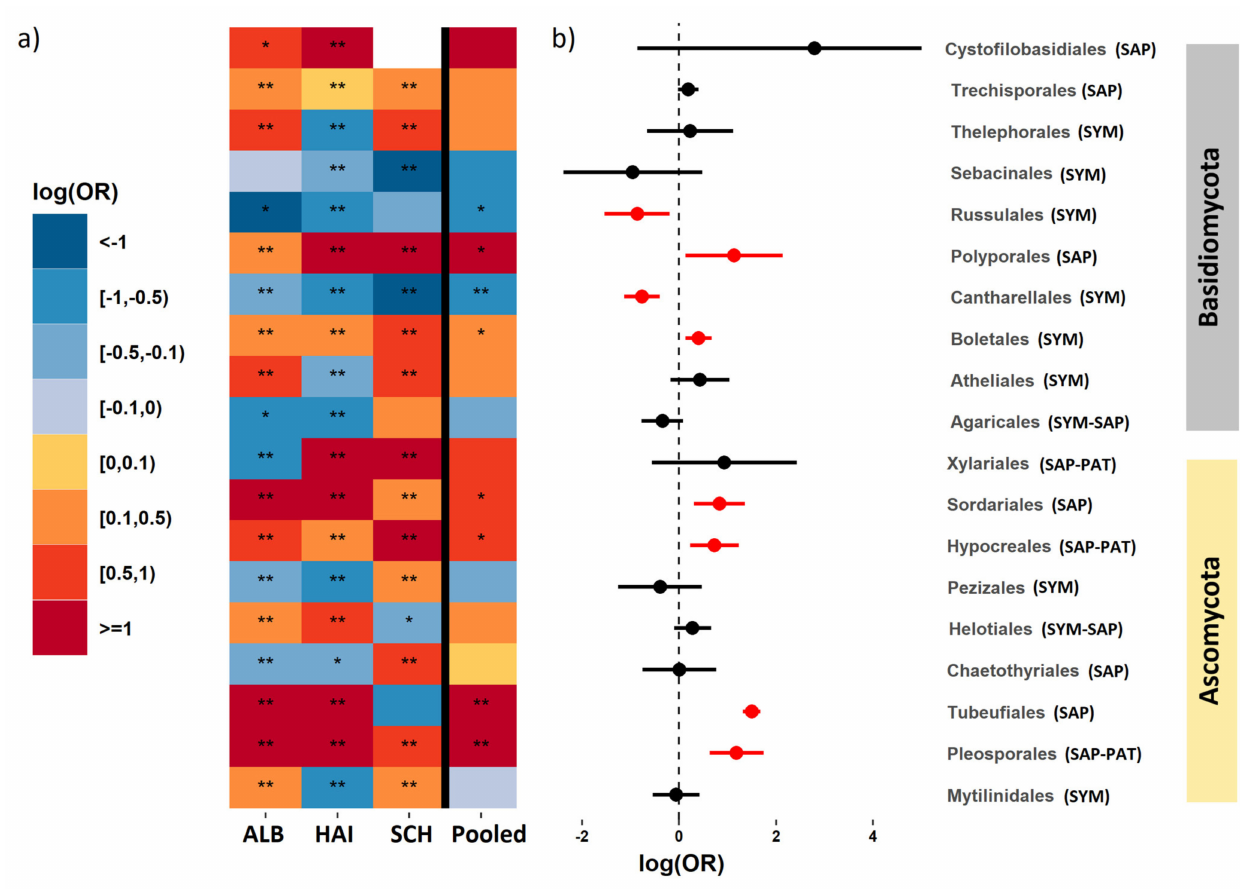
Figure 4. Effect sizes of the changes of root-associated fungal orders between organic to mineral soil. The most abundant fungal orders with >0.5% of the total number of sequences were included. Data are displayed as a heatmap of the log-odds ratio (log(OR)), which indicates the abundance in organic layer relative to that in the mineral soil. Data show the results for three regions ( a ) and the forest plot of pooled estimates across all three regions with 95% confidence intervals ( b ). ALB = Schwäbische Alb, HAI = Hainich-Dün, SCH = Schorfheide-Chorin. Red and blue colours indicate the enrichment of the root-associated fungal order in the organic layer and mineral soil, respectively. The order of Cystofilobasidiales was not present in the SCH region. Significant differences at p < 0.05 are denoted with * and at p < 0.001 with **. Significant pooled log-odds ratio (OR) estimates with p < 0.05 are shown in red colour in the forest plot ( b